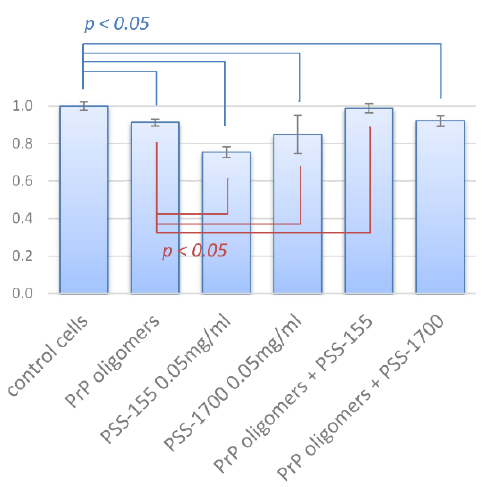
Figure 5. Neuroblastoma cells viability in the presence of PrP oligomers and PrP oligomers incubated with PSS-155 or PSS-1700 as well as PSS themselves. A statistically significant difference with control cells and control cells incubated with PrP oligomers ( p < 0.05) is marked with blue and red brackets, respectively.